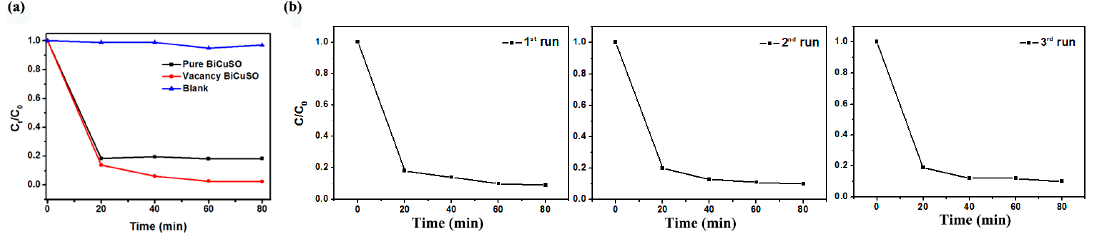
Table 2. Specific surface area and reaction rate constant of as-prepared samples Samples